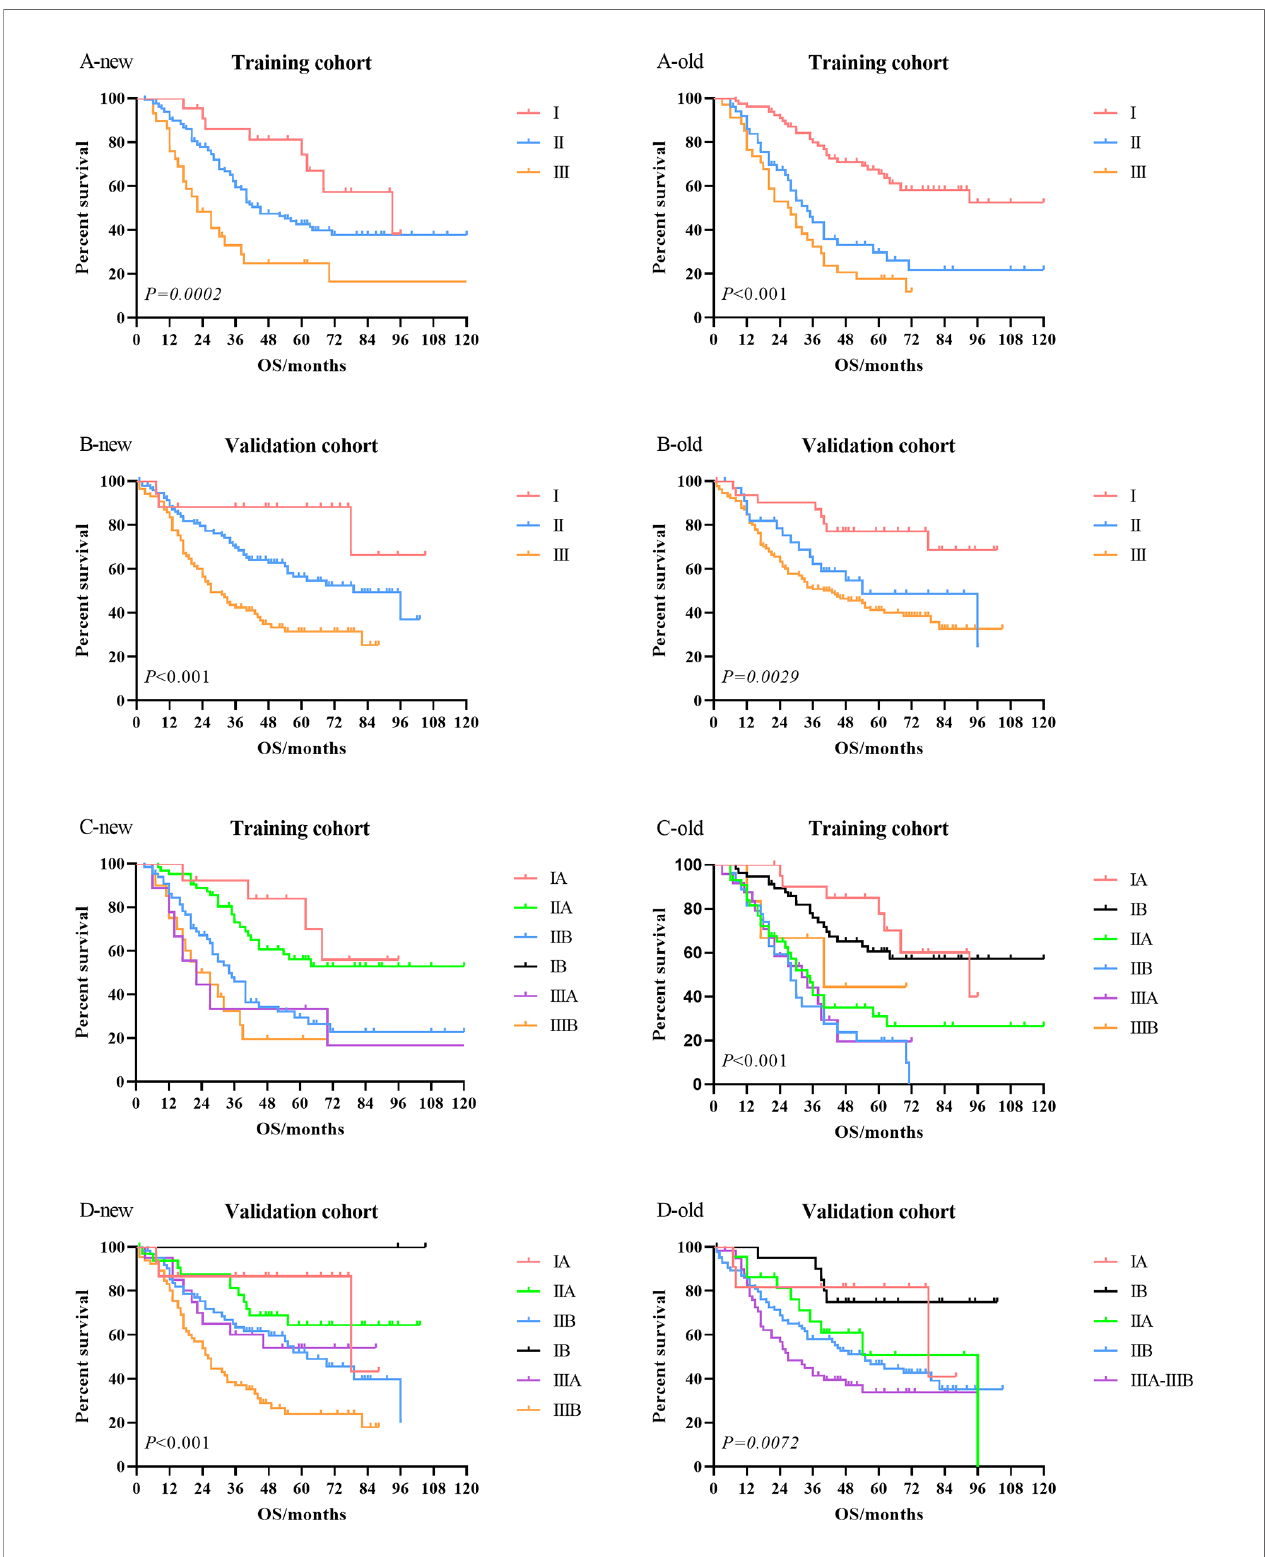
FIGURE 5 | Comparison of the Kaplan – Meier survival curves between LNR-based staging system (new) and current 8th AJCC TNM staging system (old) in the training cohort and validation cohort. LNR, lymph node ratio; AJCC, American Joint Committee on Cancer.